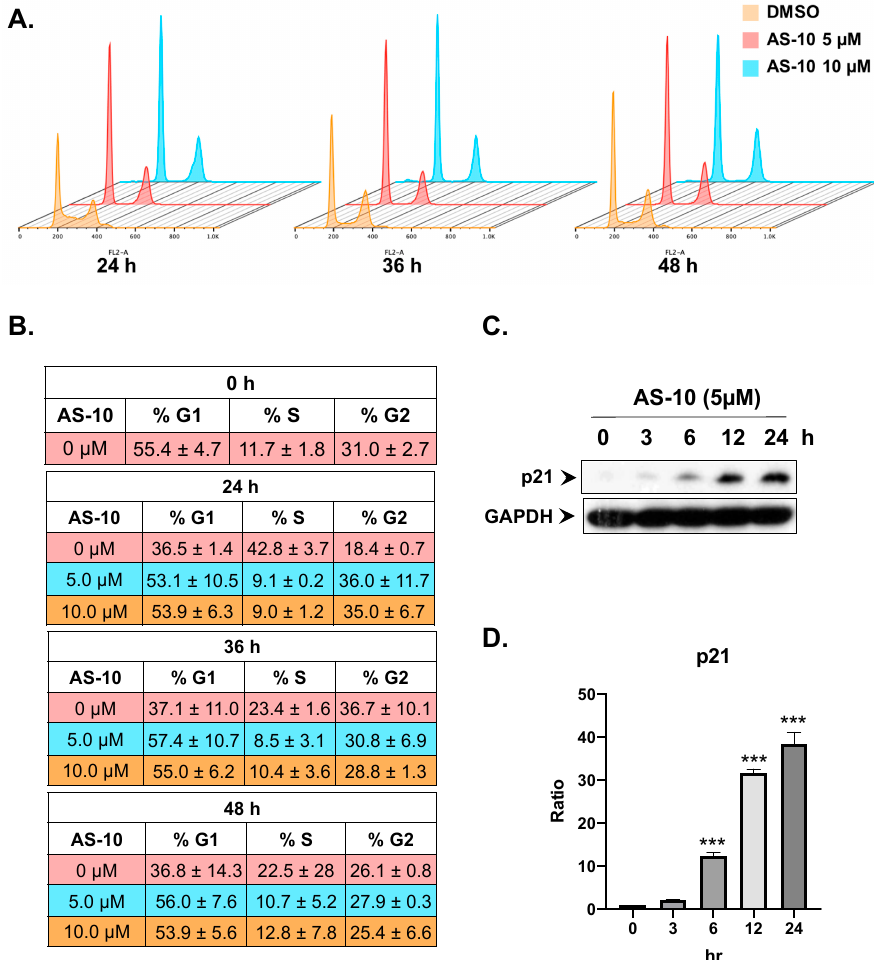
Figure 4. AS-10 induced G1 cell cycle arrest of Panc-1 cells. ( A , C ) Flow cytometric assessment of the effect of AS-10 on “synchronized” Panc-1 cell cycle progression after release from 72-h serum starvation block. The cells were treated with DMSO or AS-10 at either 5 or 10 µM for the prescribed duration and were harvested, fixed, and stained with PI for flow cytometry for enumerating G1 (first peak), S (Valley between first and second peak), and G2/M (Second peak). ( B ) Quantification of different cell cycle phases at different time points (Mean ± SD). ( C ) Western blot analysis (30 µ g of protein was used for each sample) of P21Cip1 cell cycle inhibitory protein of asynchronous Panc-1 cells treated with 5 µ M AS-10 for varying durations as indicated. GAPDH was probed as the loading control. ( D ) Densitometry analysis of P21Cip1 normalized to housekeeping protein evaluated by Image J. Data represented as the means ± SD of three independent experiments, *** ( p <